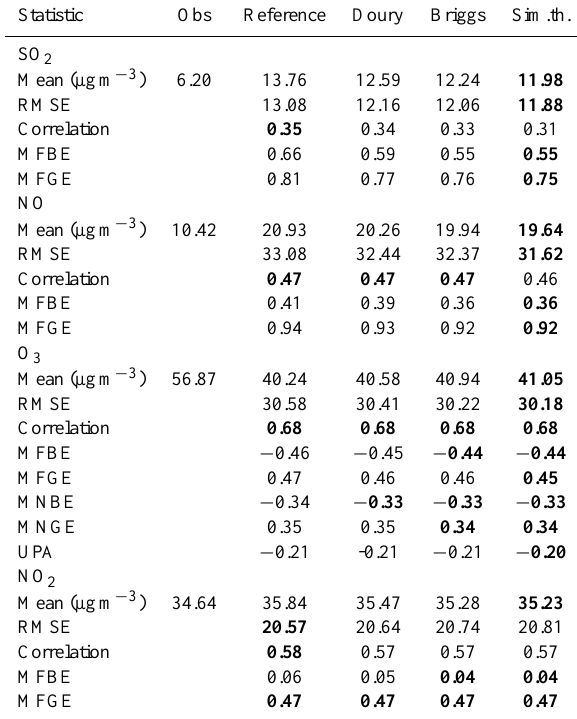
Table 1. Hourly statistics for the reference simulation with Po- lair3D (“Reference”), and plume-in-grid simulations, for three Gaussian parameterizations (“Sim.th.” stands for similarity theory). The simulation period is 2001-04-01–2001-09-27. The best statis- tics are highlighted in